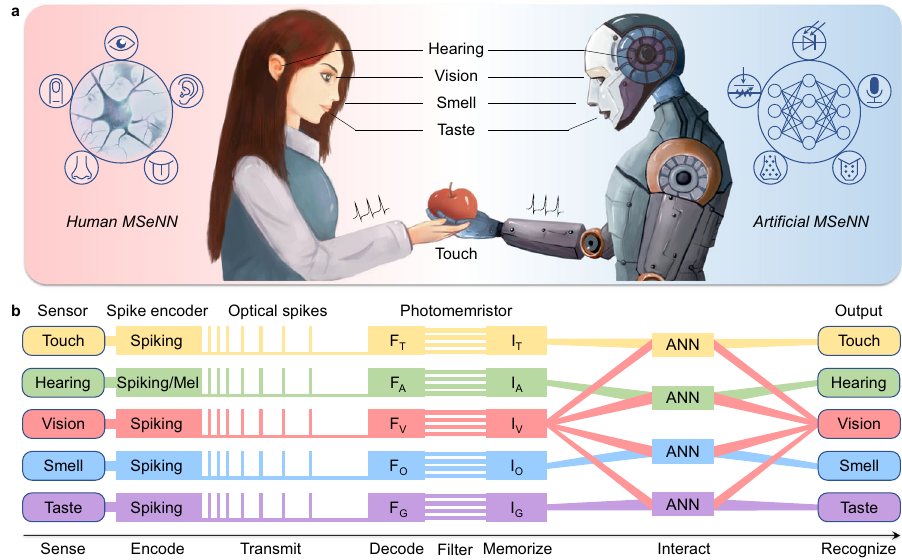
Fig. 1 Schematic of the human and arti fi cial MSeNN. a Inspired by the fi ve primary sensory systems (vision, touch, hearing, smell, taste) in the human MSeNN and their interaction via neural networks, the arti fi cial MSeNN consists of fi ve arti fi cial sensory systems and their integration via ANNs. b Operational diagram of the arti fi cial MSeNN. Sensors (photodetectors, pressure sensors, sound detectors, and simulated smell and taste receptors) convert external stimuli to potentials. Spike encoders encode potentials into optical spikes for communication. The transmitted information is decoded, fi ltered, and memorized by photomemristors, and the signals are crossmodally integrated and associated by ANNs for crossmodal recognition and